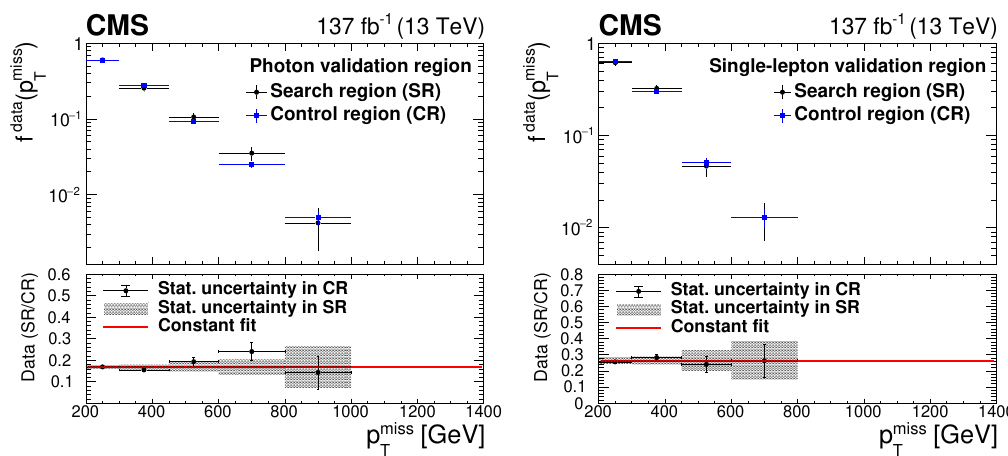
Figure 7 . Comparison of the p miss shape between the Z signal window and p miss control region for T T the photon (left) and single-lepton (right) validation samples in data. The upper panels show the unit-normalized p miss distributions f data ( p miss ) in the two regions, while the lower panels show the T T ratio of the number of events in the search region to that in the control region. A (cid:12)t to a constant is included in the lower panels to show the average ratio. The horizontal bars on the markers indicate the widths of the search bins. In the lower panel the statistical uncertainties in the search and control region yields are denoted by the shading and vertical bars,